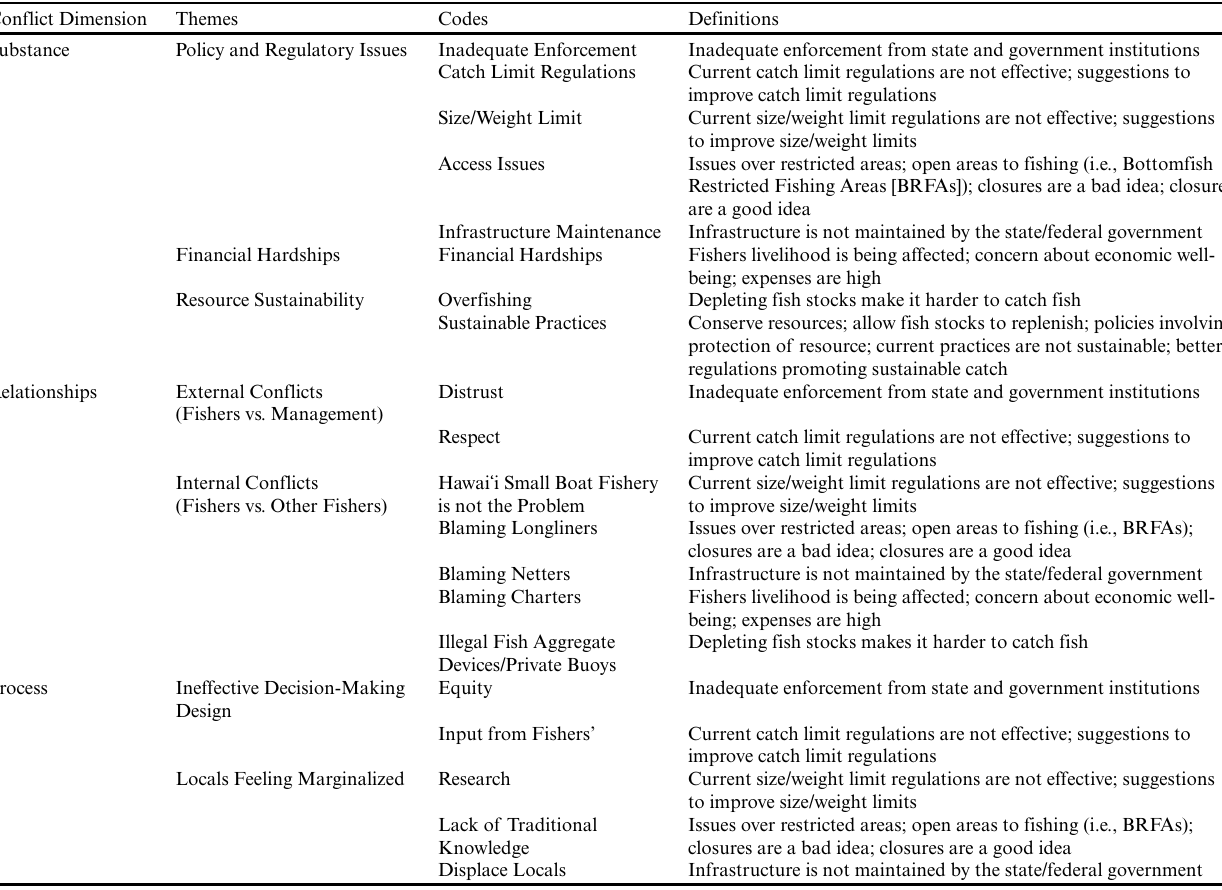
Table 1 . Codes and definition of final coding